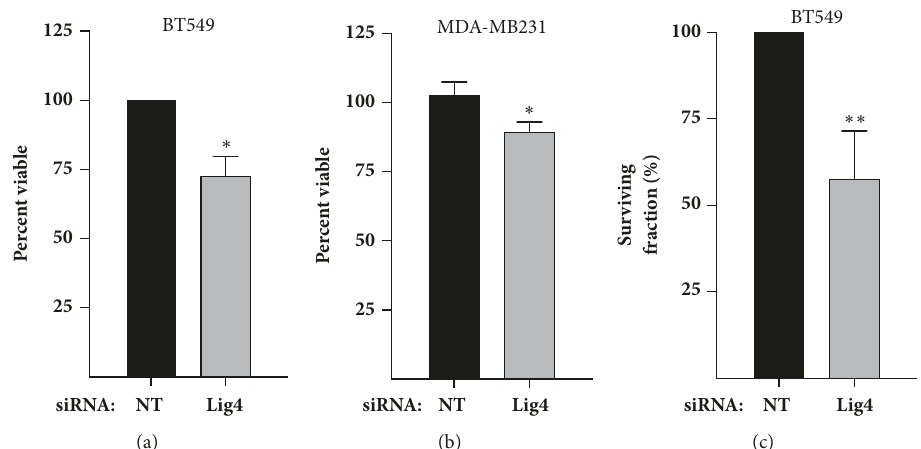
Figure 2: Lig 4 d epletion re du ce d cell u lar via b ilit y an d colon y for m ing a b ilit y . (a, b) Cell viability assessed using CellTiter Glo assay 72 hr after transfection with siRNA targeting Lig4 or scrambled control (NT; ∗ p < 0.05). (c) BT549 cells depleted of Lig4 or scrambled control and subjected to clonogenic assay ( ∗∗ p < 0.01,